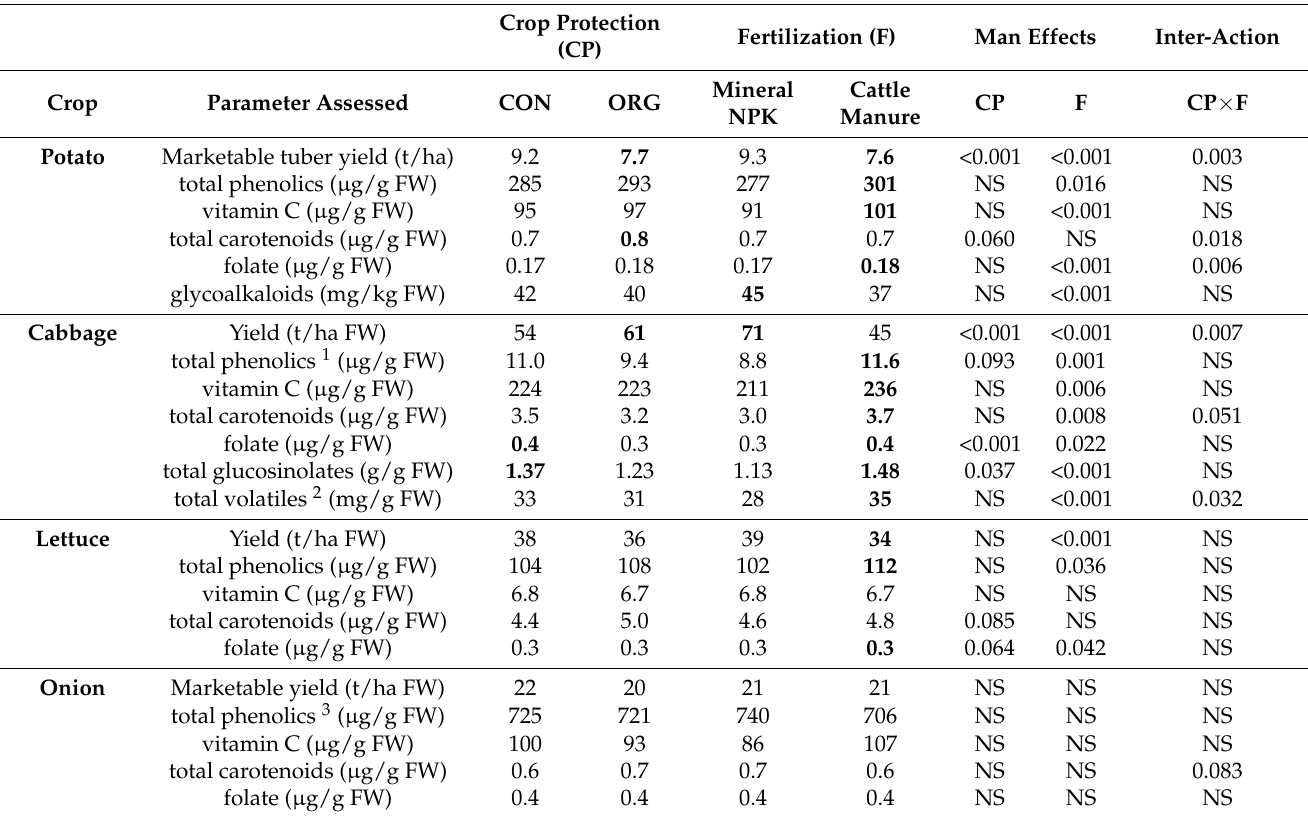
Table 1. Effect of the crop protection (organic versus conventional) and fertilization regime (mineral NPK vs cattle manure) on nutritionally relevant phytochemicals in potato, cabbage and lettuce grown in the NFSC trial data from [58]; values shown are main effect means; yield results are from 9, 6, 4 and 4 growing seasons for potato, cabbage, lettuce and onion ( Allium cepa L.), respectively; phytochemical and/or nitrate results are from 3 or 4 growing seasons for potato, cabbage, lettuce and